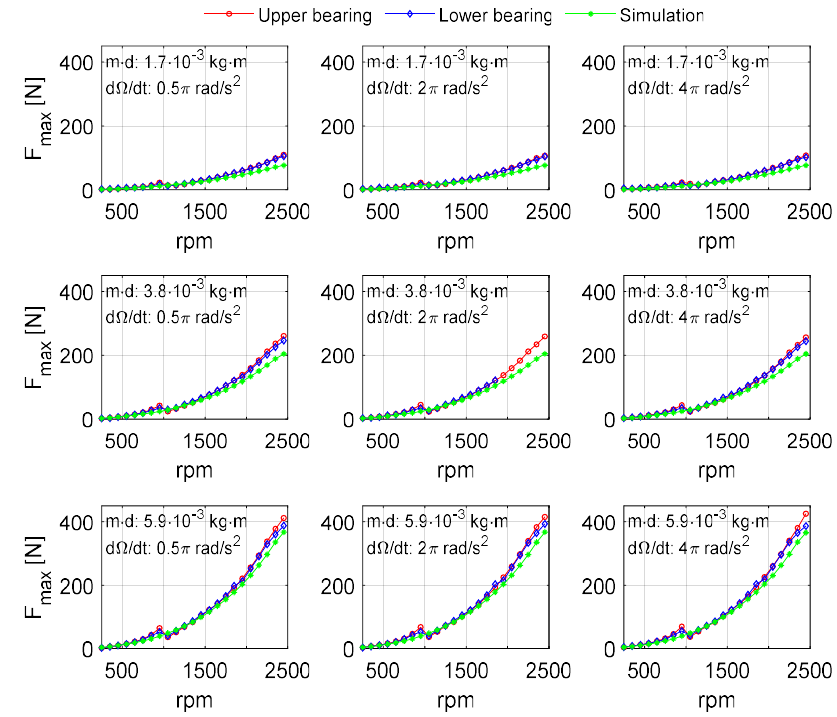
Figure 22. The simulated and measured bearing forces for nine different cases: m · d: unbalance mag- nitude and d Ω /dt: angular acceleration. The lower bearing force measurement with 3.8 × 10 − 3 kg · m and 2 π rad/s 2 has some discrepancies after 1950 rpm and is excluded from the